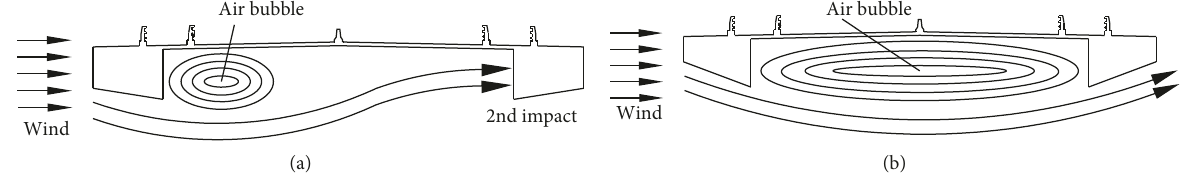
Figure 3: Streamline for the sloped box slope from CFD result [12]: (a) box slope angle � 9 ° (B/H ratio 9.2); (b) box slope angle � 21 ° (B/H ratio